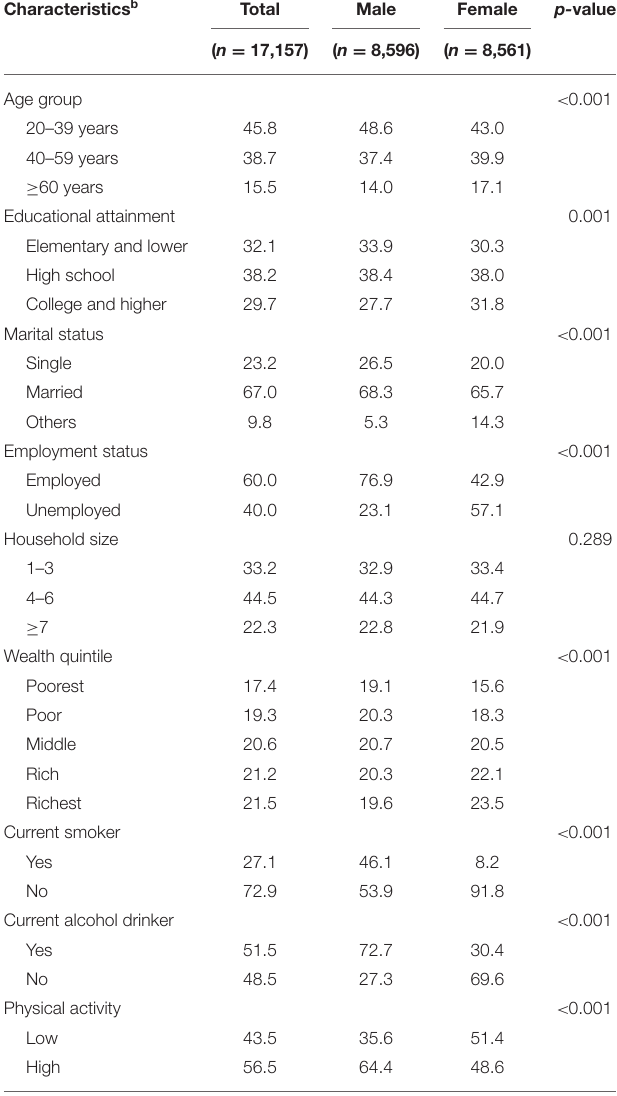
TABLE 1 | Socio-demographic and lifestyle characteristics of study participants a